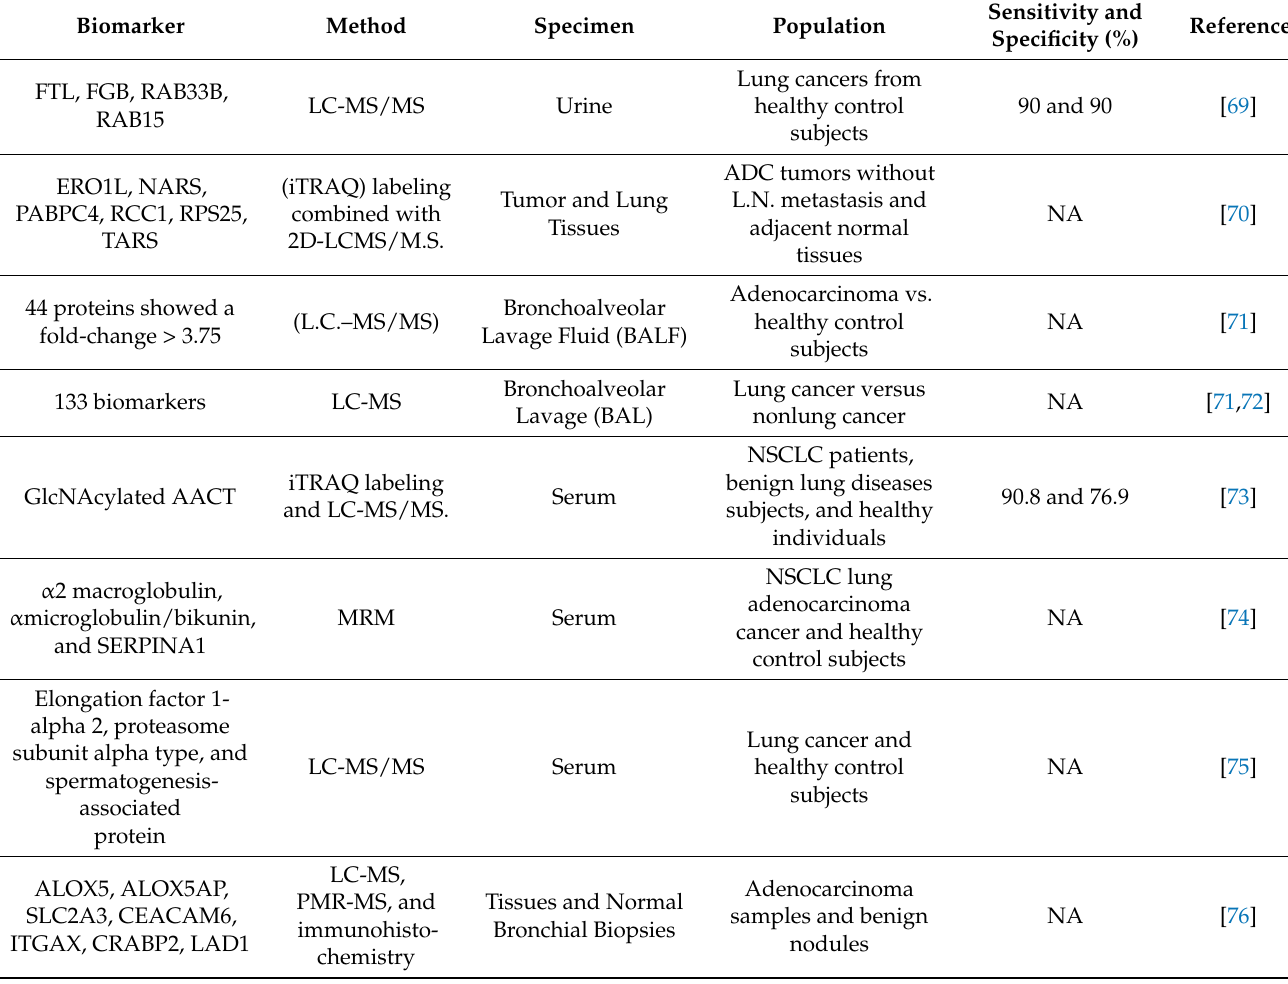
Table 3. Protein biomarkers for early detection of